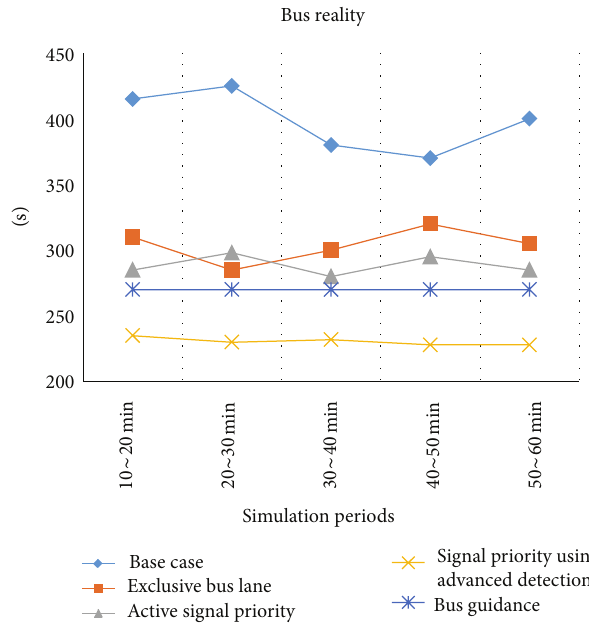
Figure 5: Reliability of bus travel time in five scenarios along Eastbound Shengli road. Table 4: Average and standard deviation of bus travel time.